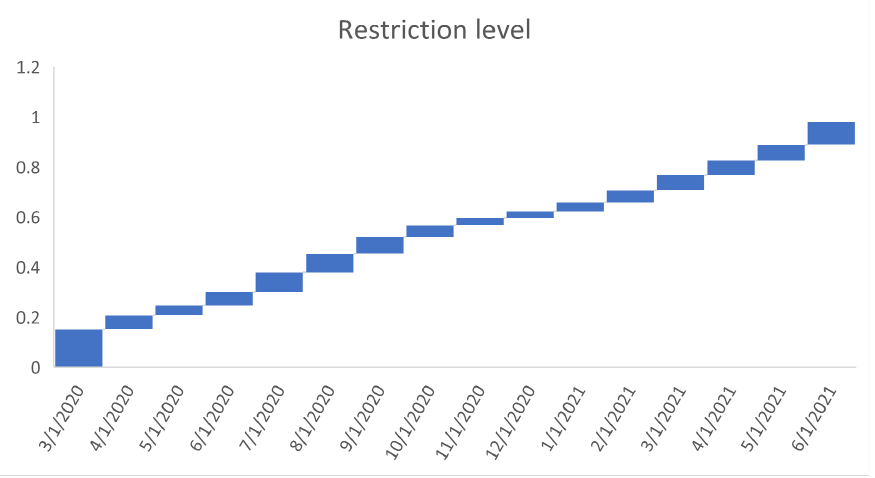
Figure 7. Progressive restriction levels in US. For readability, note that 4/1/2020 refers 1 April 2020.